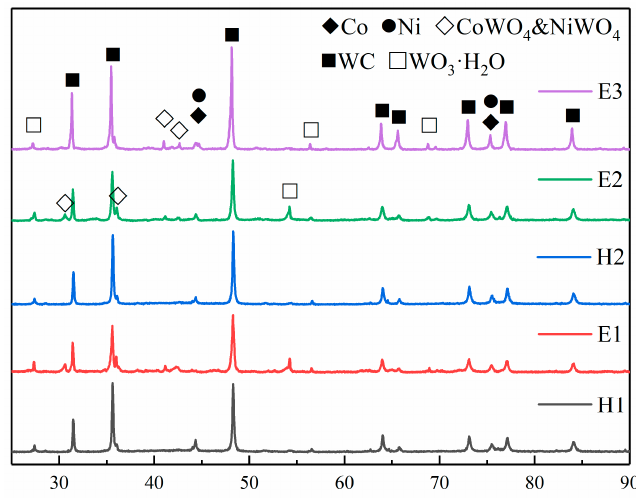
Figure 11. XRD results after corrosion.